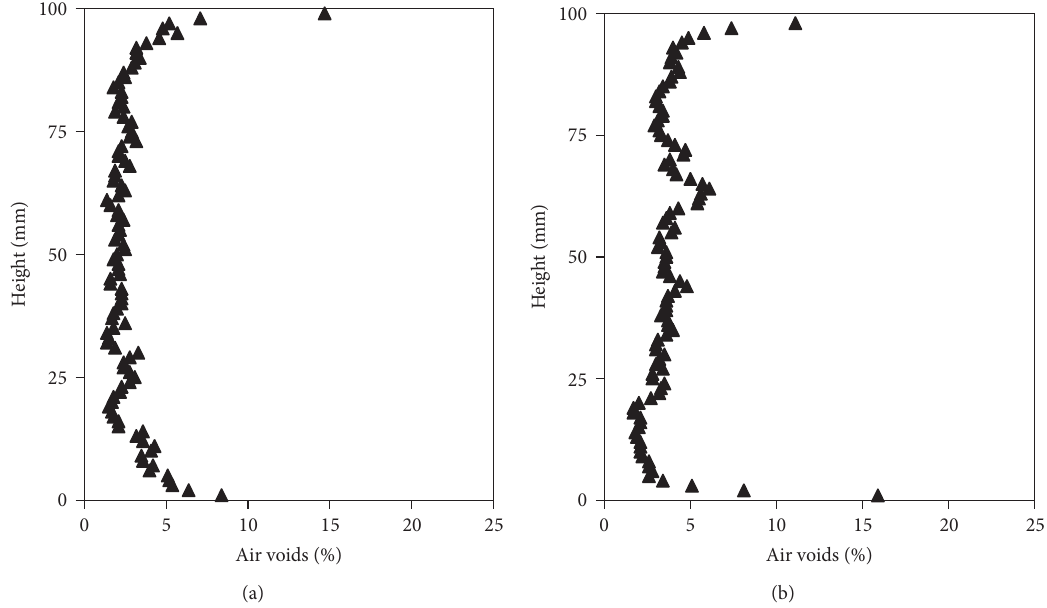
Figure 5: Air voids distribution in 100 mm × 100 mm specimens for (a) V-Mix and (b) RA-Mix. at the same point in the line array with every